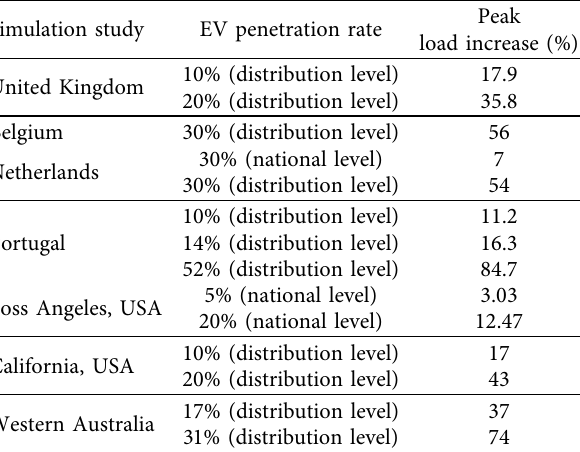
Table 1: Impact of uncoordinated EV charging on the peak load for various simulation studies from the